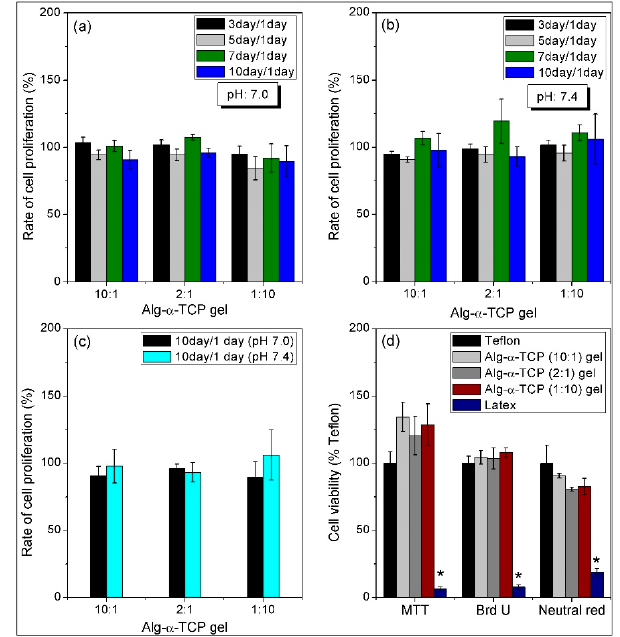
Figure 8. Rate of MC3T3 cell proliferation inside the Alg- α -TCP (10:1, 2:1 and 1:10) gels at ( a ) pH 7.0; ( b ) pH 7.4; ( c ) comparative study of cell proliferation at pH 7.0 and pH 7.4 after 10 days and ( d ) cytotoxicity of hybrid gels by the MTT, BrdU and Neutral red assays.